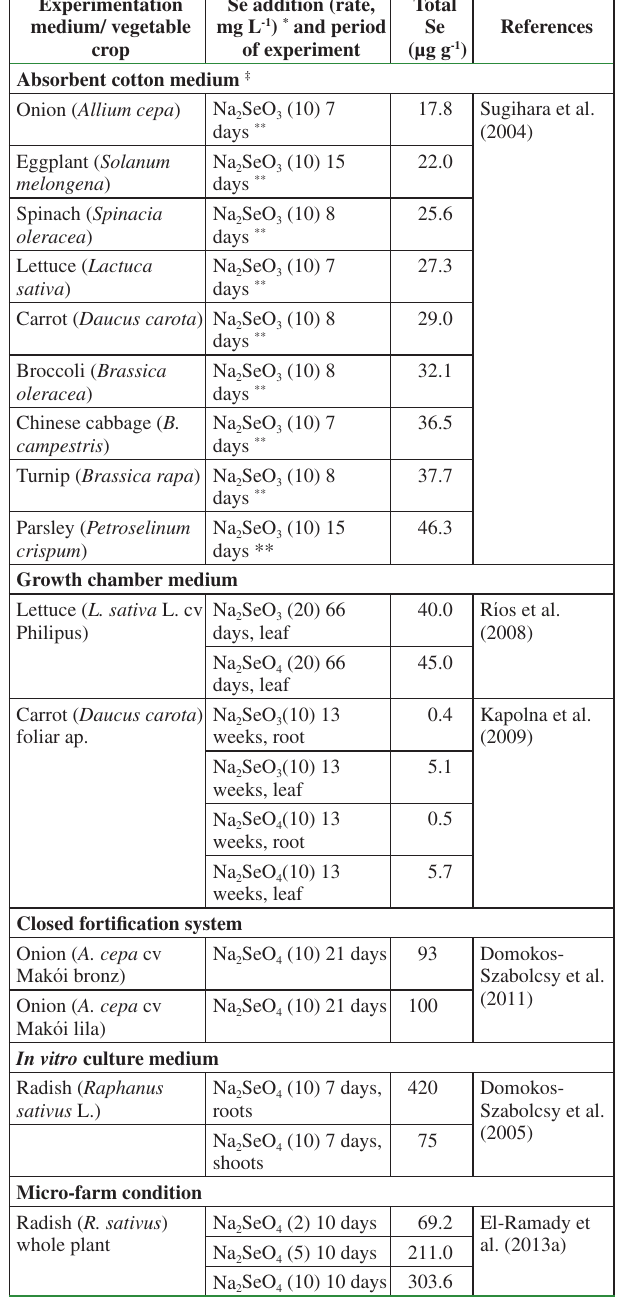
Cichory ( Cichorium intybus )